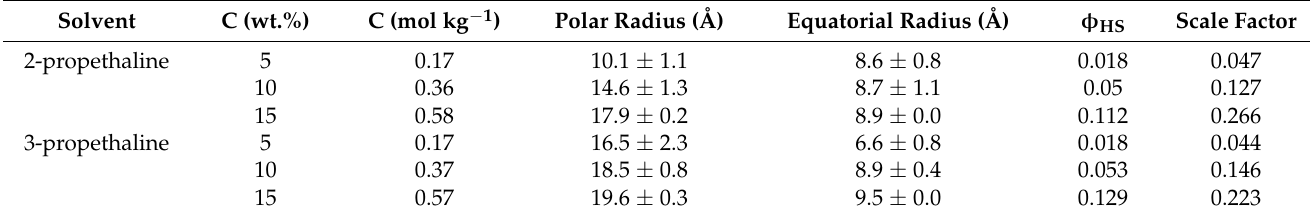
Table 3. SAXS fitting parameters for ternary eutectic systems.